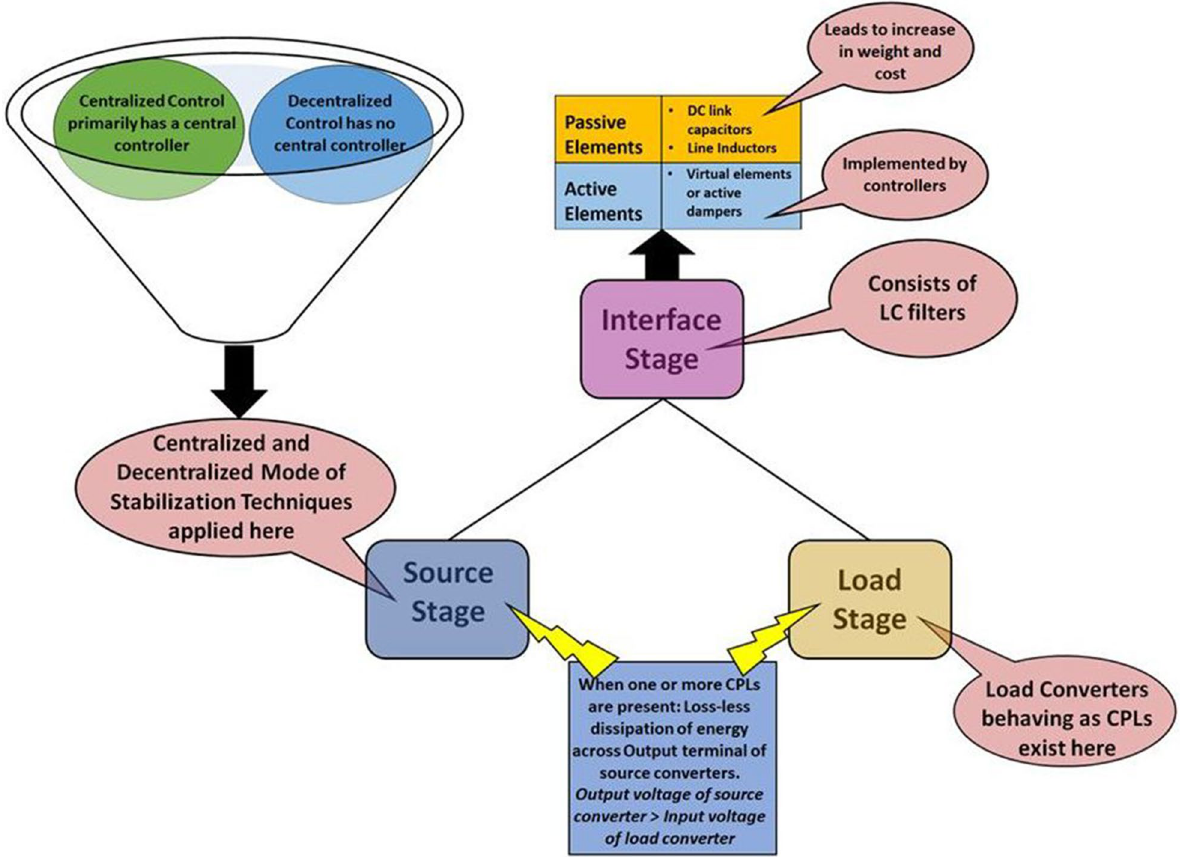
Fig. 5 Detailed description of 3 stabilization stages of